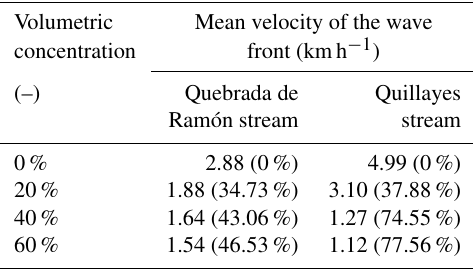
Table 1. Mean velocity of the front for different sediment concen- trations. In parentheses, the percentage change from clear water is shown.